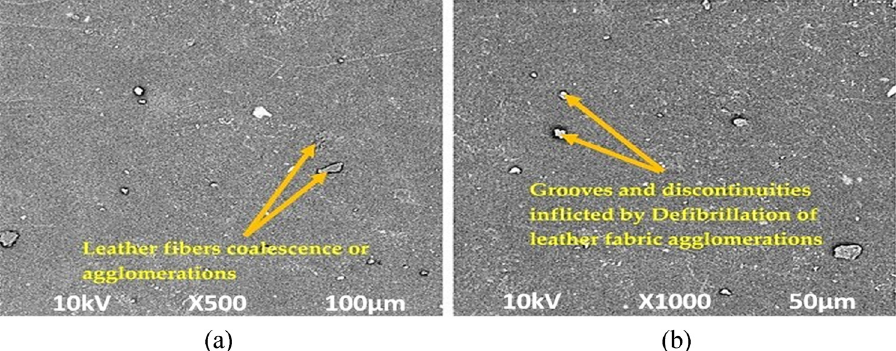
Figure 50: Micrographs of leather bu ffi ng dust/recycled EVA polymer composites at a magni fi cation of ( a ) 500 × and ( b ) 1,000 ×